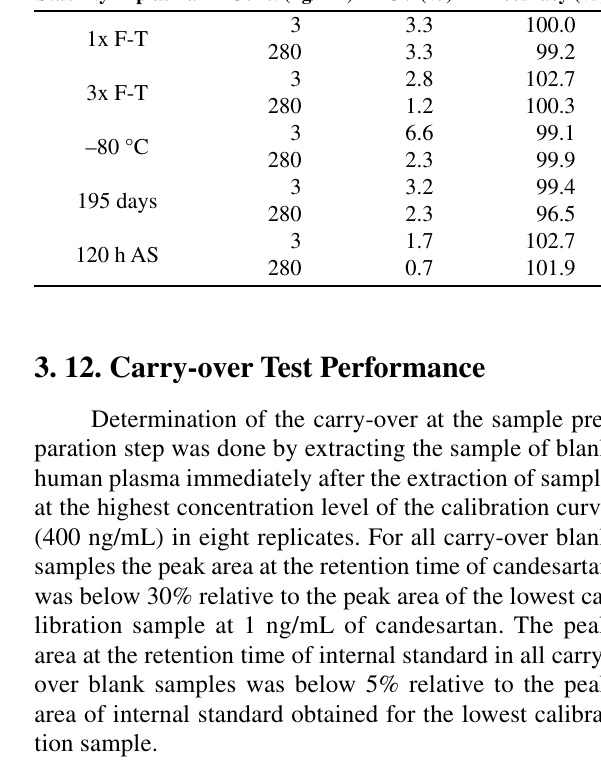
Table 5: Stability of candesartan in human plasma. Stability in